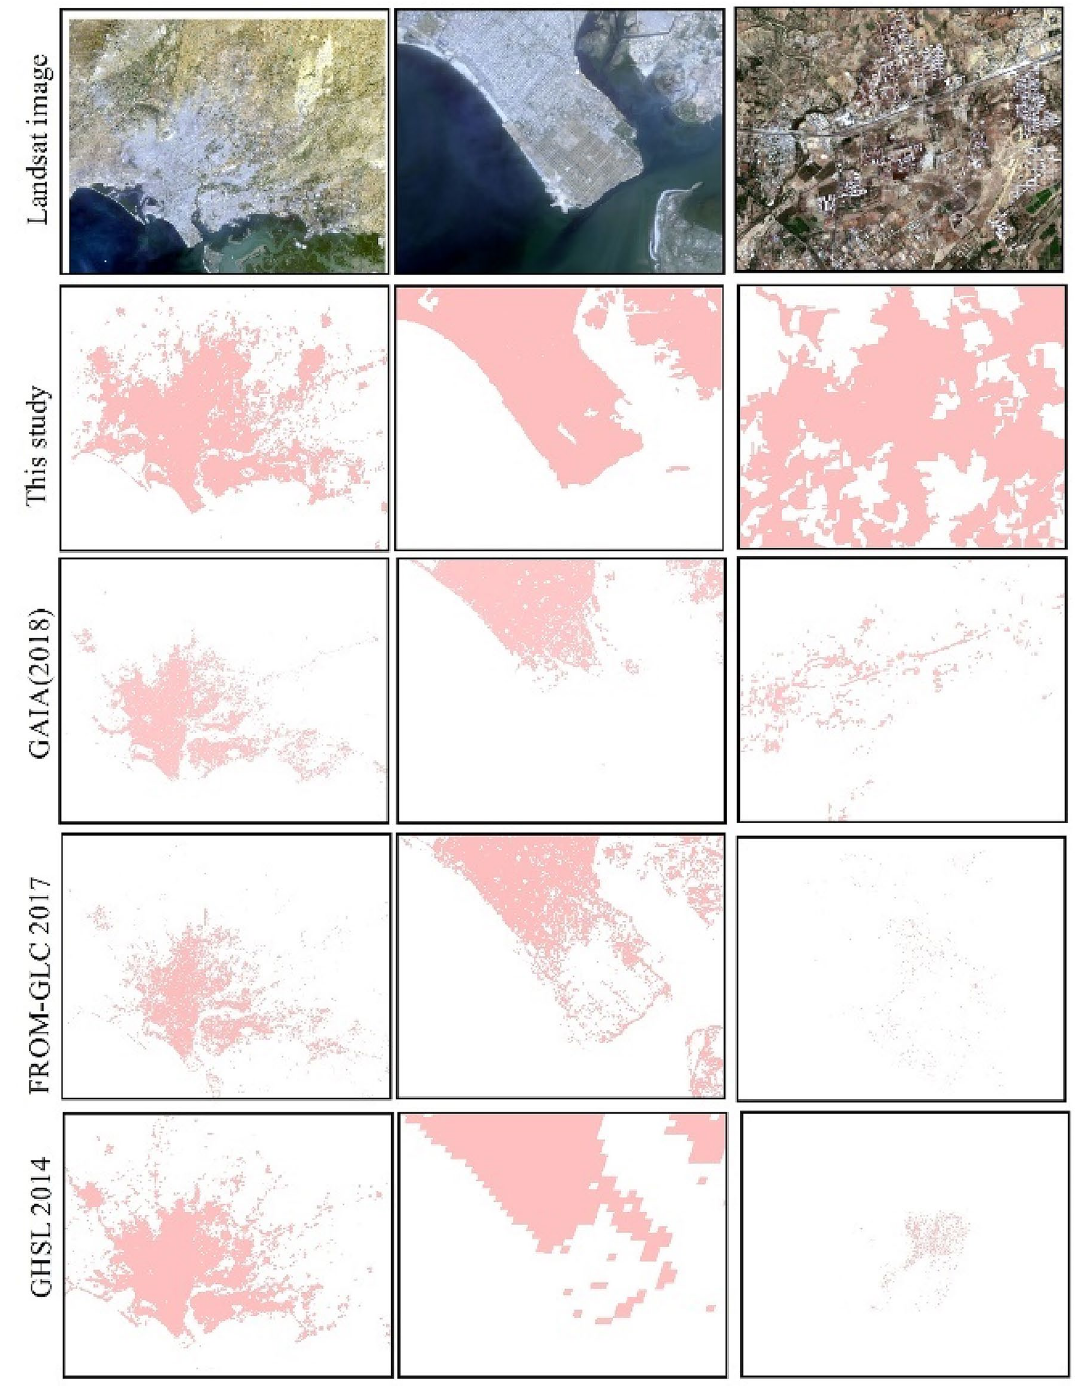
Figure 8. Comparison among this study, GAIA, FROM-GLC, and GHSL. Landsat OLI images from 2020 are shown in red, green, and blue (the map created in ESRI ArcMap 10.2, https:// suppo rt. esri. com/ zh- cn/ produ cts/ deskt op/ arcgis- deskt op/ arcmap/